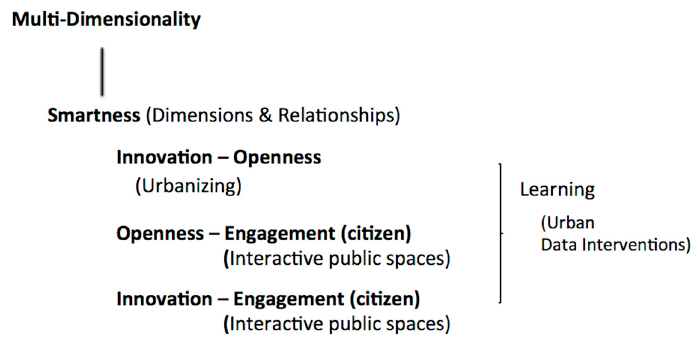
Figure 4. Smartness multi-dimensionality: dimensions and relationships for learning in smart cities.